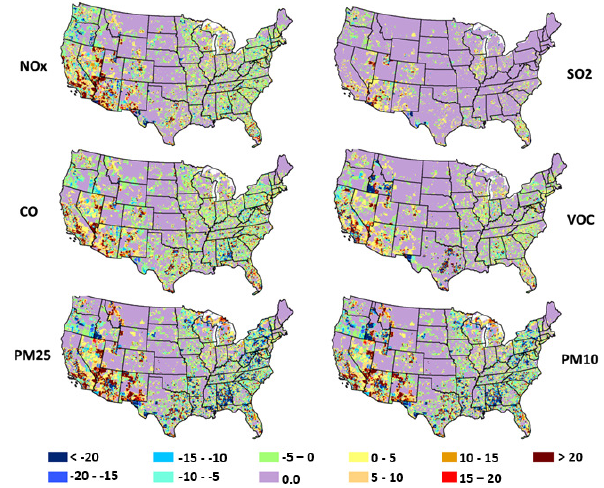
Figure 11. FD (%) of annual 2050 emissions, Future minus Fu- ture05Surr , for grid cells in the CONUS 12km domain. ( Fu- ture : 2050 inventory, 2050 surrogates, county growth factors; Fu- ture05Surr : 2050 inventory, 2005 surrogates, county growth fac-